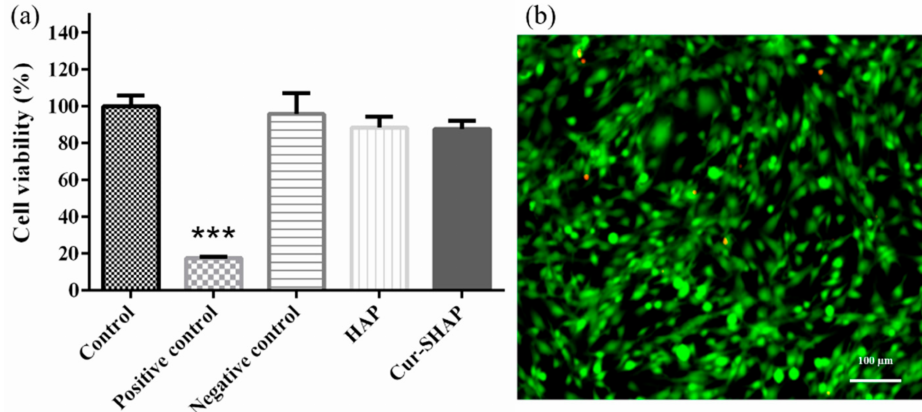
Figure 6. Cytotoxicity and cell viability assay. ( a ) Cell viability evaluation of Cur-SHAP using the WST-1 assay. ( n = 6, *** p < 0.001 compared to the control). Zinc diethyldithiocarbamate and aluminum oxide served as the positive control and negative control, respectively. ( b ) Cytotoxicity assay of Cur-SHAP using LIVE/DEAD staining.